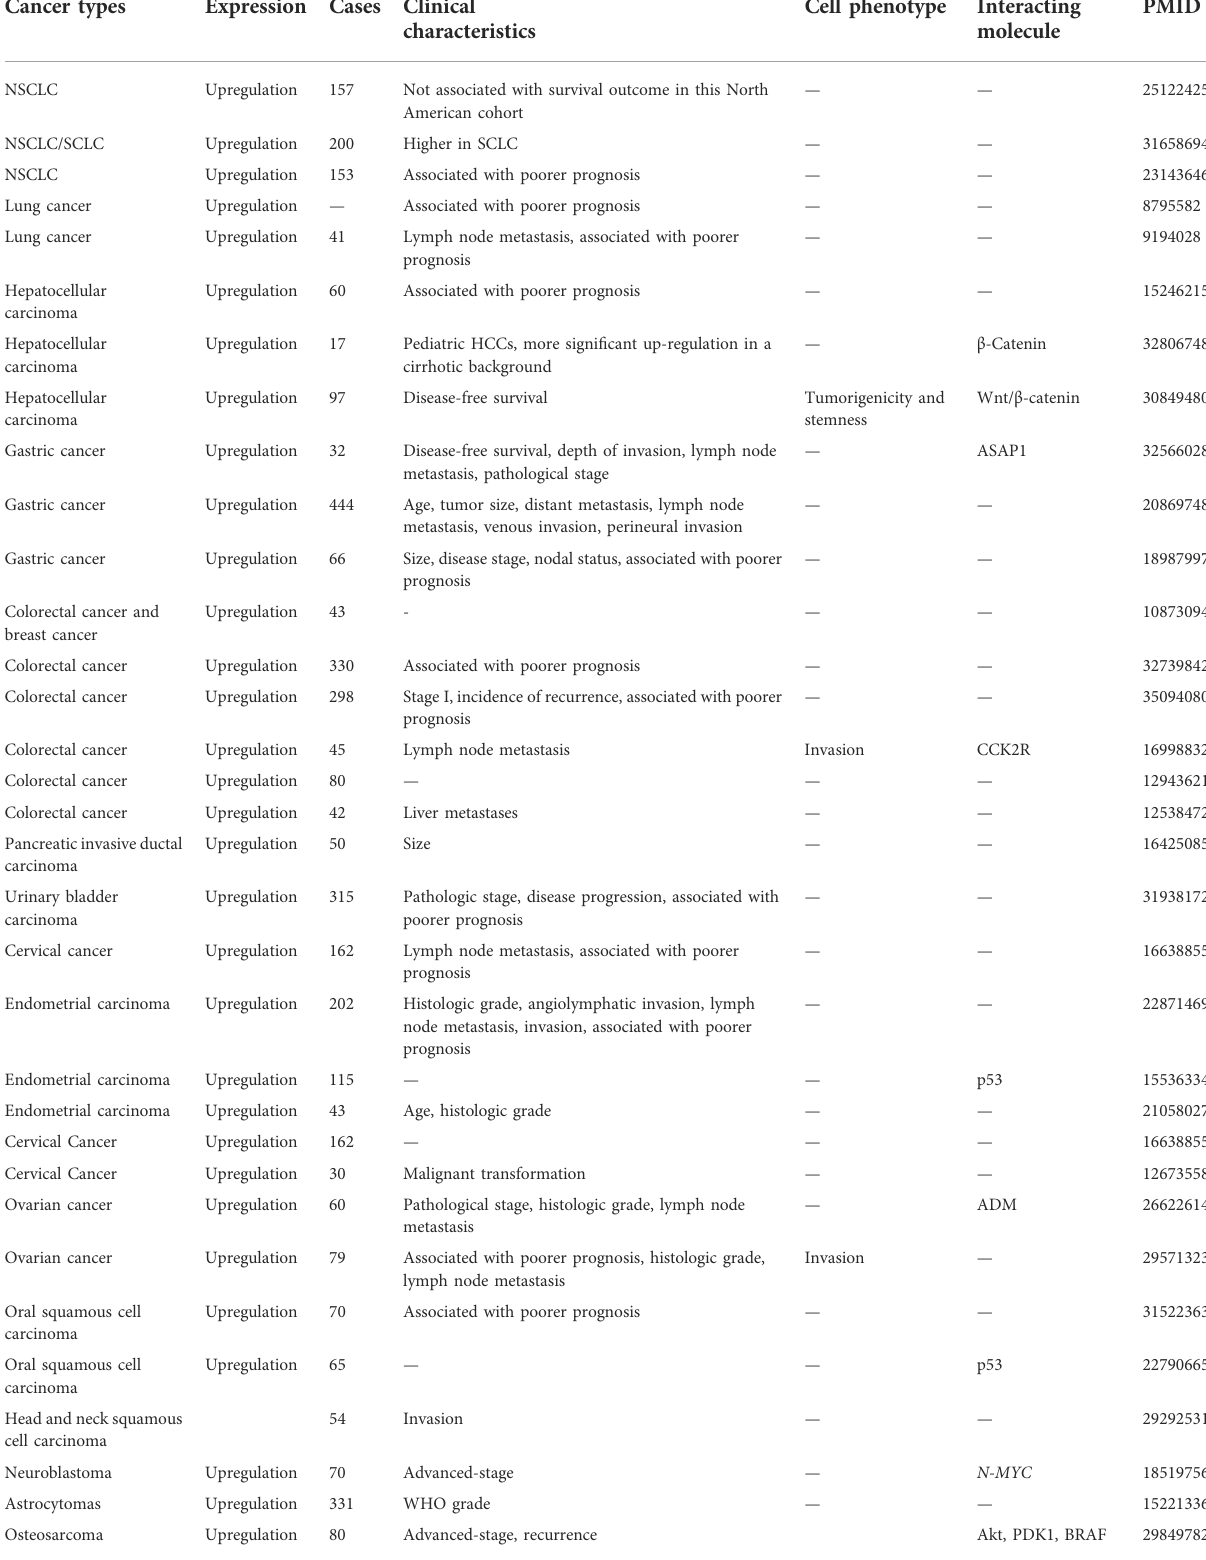
TABLE 1 Summary of the clinical characteristics of FAK in malignant